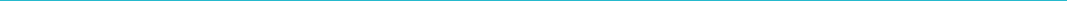
Figure 1: Disease characteristics and organ involvement Switzerland and Europe.Peripheral vasculopathy: digital ulcers ever; joint involve- ment: any of joint contracture, joint synovitis or tendon friction rubs; muscular involvement: any of muscle weakness or muscle atrophy; GIT (gastrointestinal tract) involvement: any of oesophageal (dysphagia, reflux), stomach or intestinal symptoms; ILD (interstitial lung disease): lung fibrosis on x-ray or HRCT; PAH (pulmonary artery hypertension): PAPsys >40 mm Hg by echo; heart involvement: left ventricular ejection fraction <45%; kidney involvement: renal